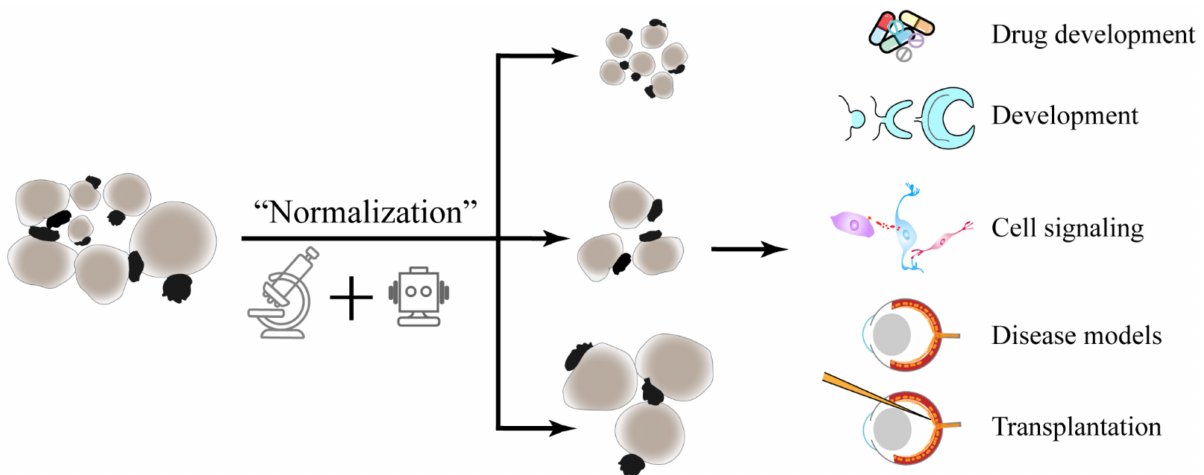
Figure 3. Normalizing heterogeneous retinal organoids by artificial intelligence. Heterogeneous retinal organoids are ‘normalized’ and grouped by their sizes, colors, fluorescent protein-tagged markers, or other features through image recognition and machine learning. These normalized organoids would decrease the variations during drug screening, disease models, developmental studies, and so